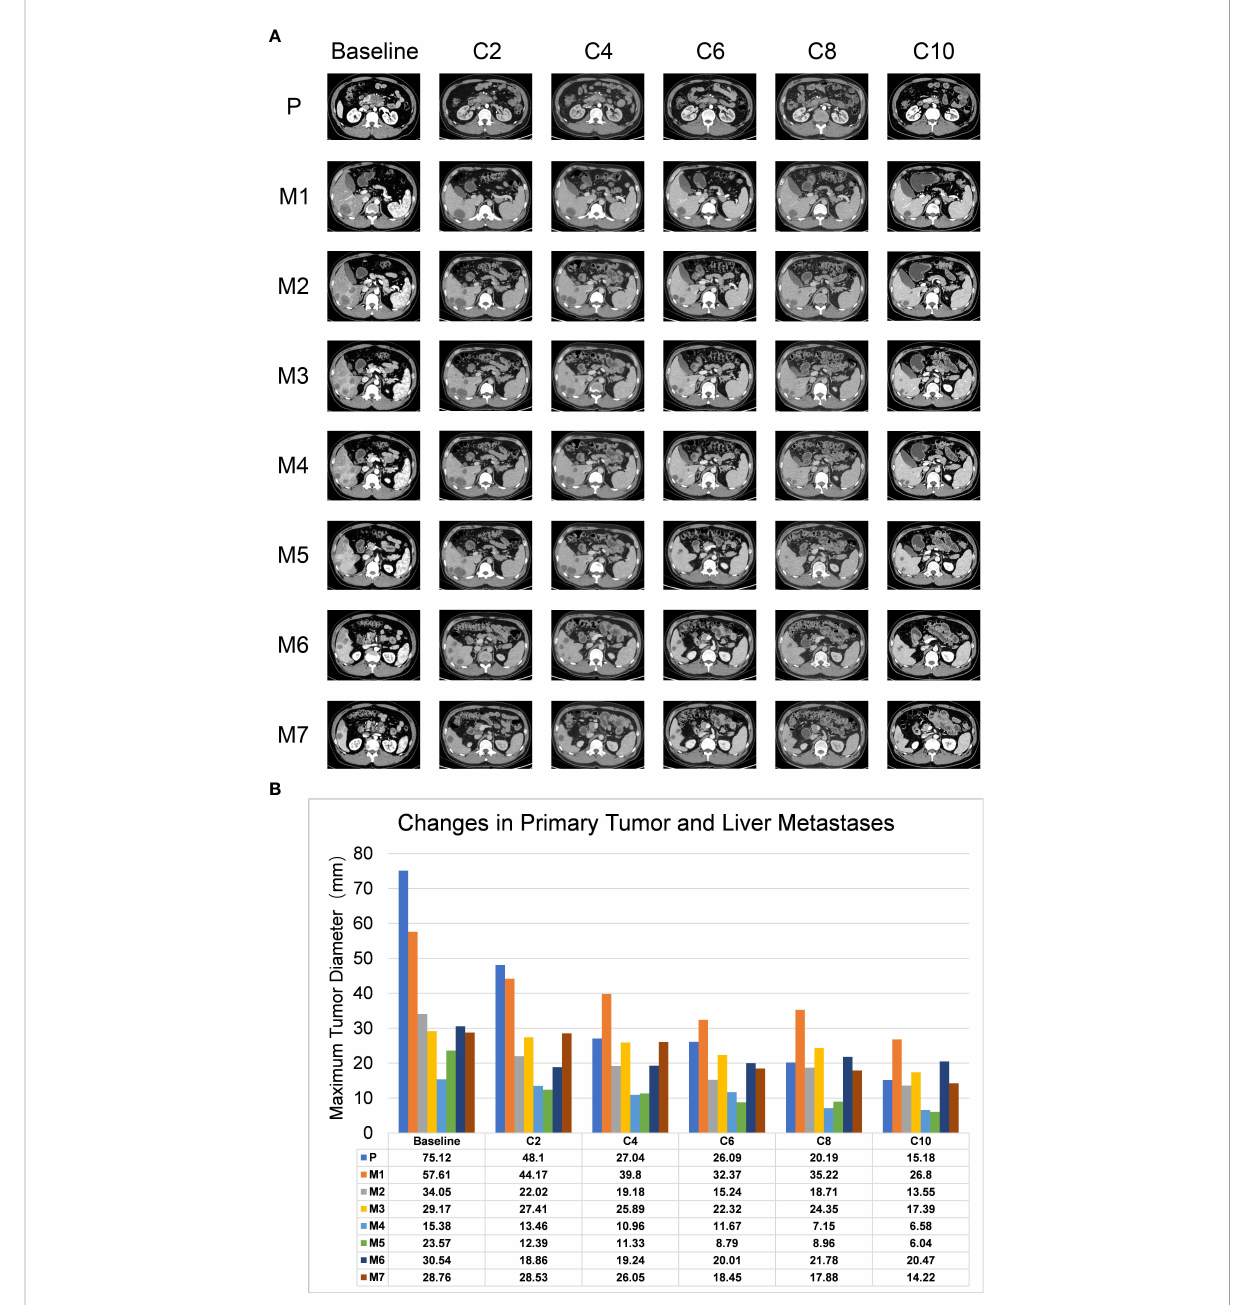
FIGURE 1 Representative images of CT scans for lesions. (A) CT scans showed changes in primary and metastatic lesions after combination therapy. C2- C10 represents the re-examination every two cycles, P represents the primary lesions, and M1-M7 represents the 7 liver metastases. (B) The histogram demonstrated the change trends in primary tumor and liver metastases, including maximum tumor diameter (Y-axis) corresponding to the treatment timeline. The X-axis shows the treatment